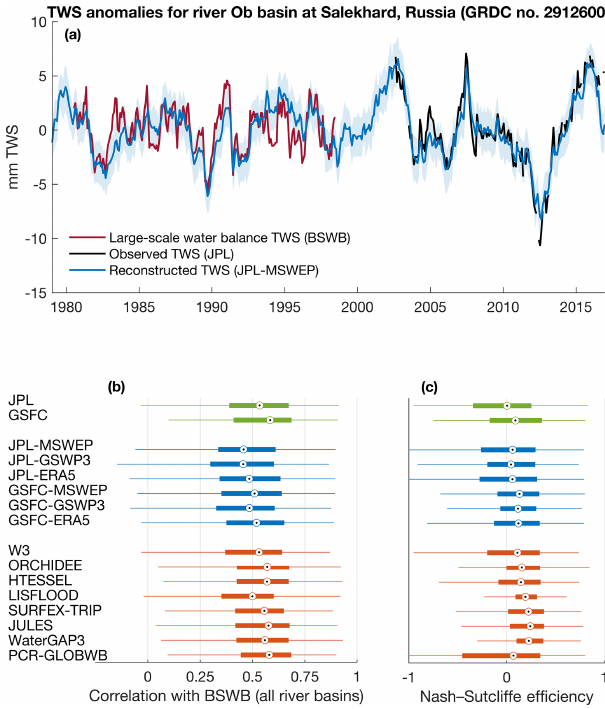
Figure 12. (a) Comparison between TWS anomalies derived from atmospheric basin-scale water balance (BSWB), GRACE observa- tions (JPL), and the GRACE reconstruction (JPL-MSWEP dataset). (b–c) Global box plots of the agreement between various TWS products and BSWB estimates (based on the performance metrics at 341 large basins). The scale factors were applied to the JPL data for this specific